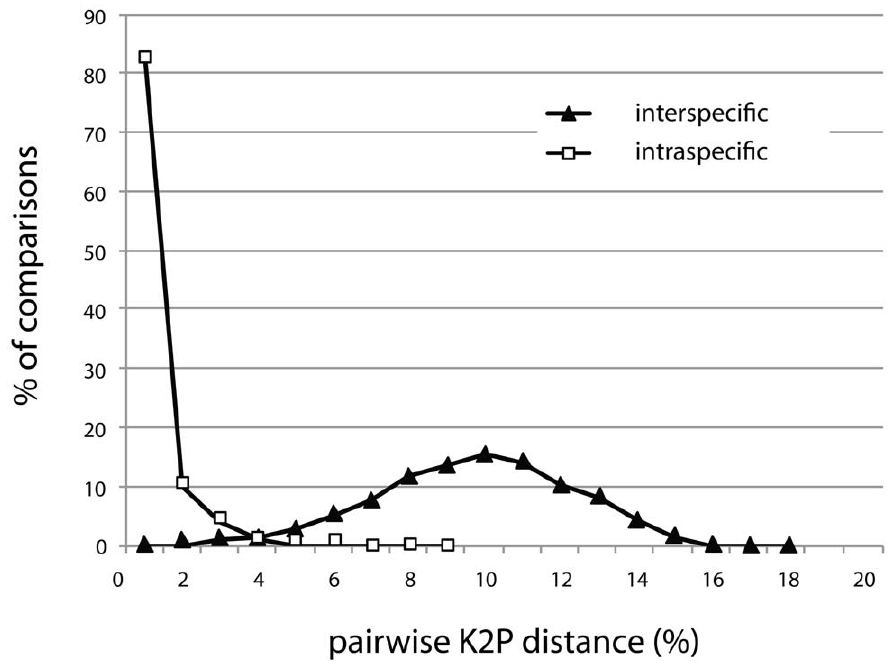
Figure 1. Combined histograms of pairwise Kimura 2-Parameter (K2P) sequence variation. Solid triangles indicate interspecific divergences between 116 congeneric taxa (70,580 comparisons) while the open squares indicate intraspecific divergences in the 339 species with multiple samples (11,949 comparisons).